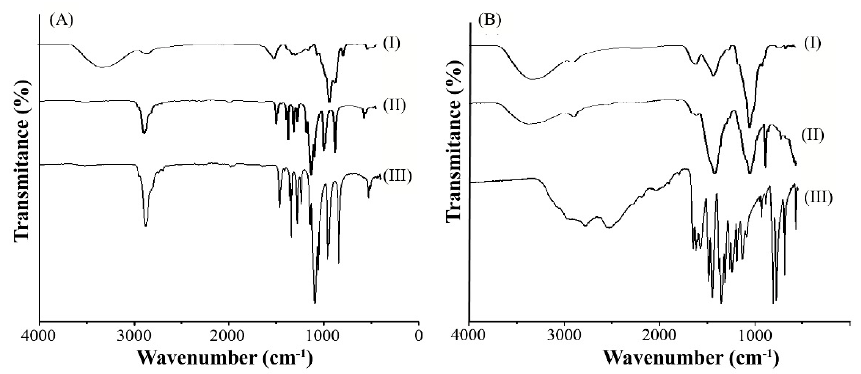
Figure 6. ATR-IR spectra ( A ) of xylan (I), XBM (II), and PEG (III) and ( B ) formulation XBM-Ca-F9 without drug (I), XBM-Ca-F9 loaded with 5-ASA (II), and 5-ASA alone (III).